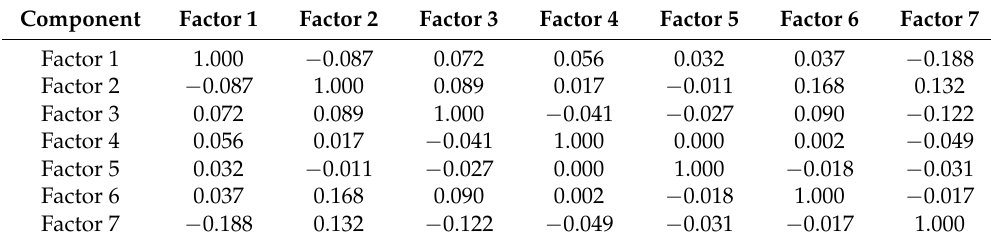
Figure 4. The screen plot for the repeated PCA. A clear demonstration of the elbow of the screen plot. Twelve factors emerged with eigenvalue more than 1. Seven factor-solution would be the best factor solution according the scree plot. Table 8. Correlation matrix table between the new factors (repeated PCA).